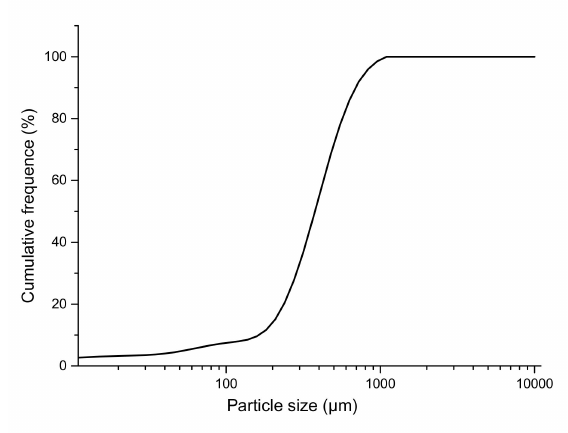
Figure 2. Grain size distribution